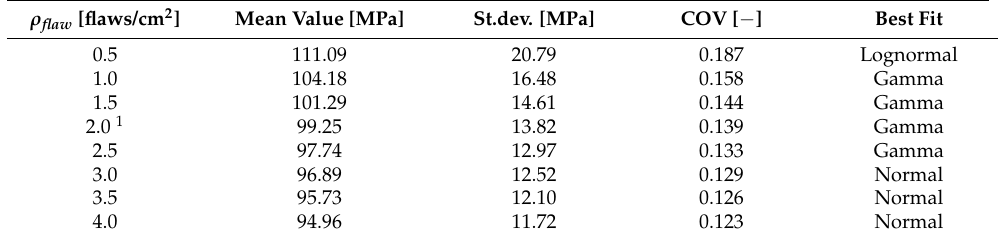
Table 7. Data for a varying flaw density.